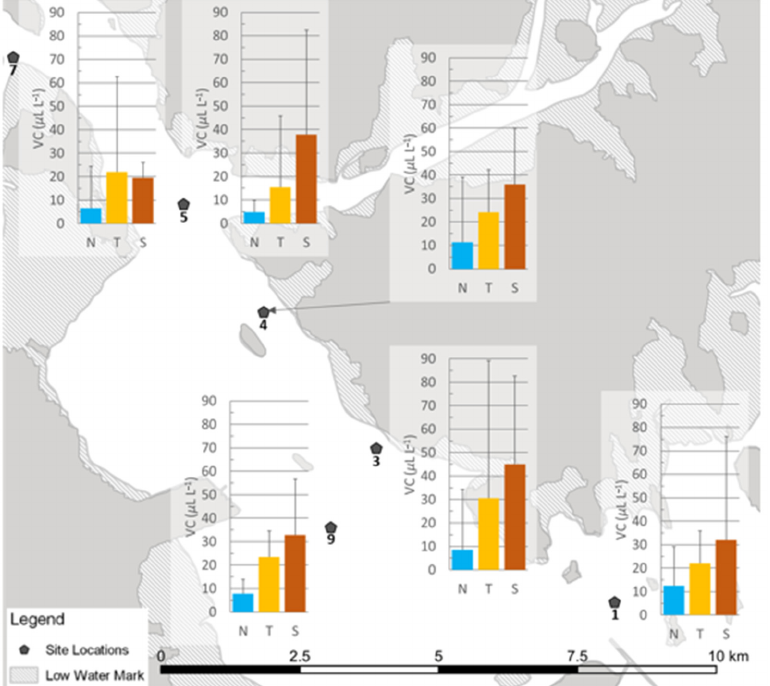
Figure 2. Spatial variation of depth-averaged VC ± standard deviation at the lower-estuary (Site 1), mid-estuary (Sites 3, 4, and 9), and upper-estuary (Sites 5 and 7). LISST profile sites during neap (N; blue bars), transitional (T; orange bars), and spring (S; brown bars) tide conditions. The high-water boundaries represent the region during the period of sampling.